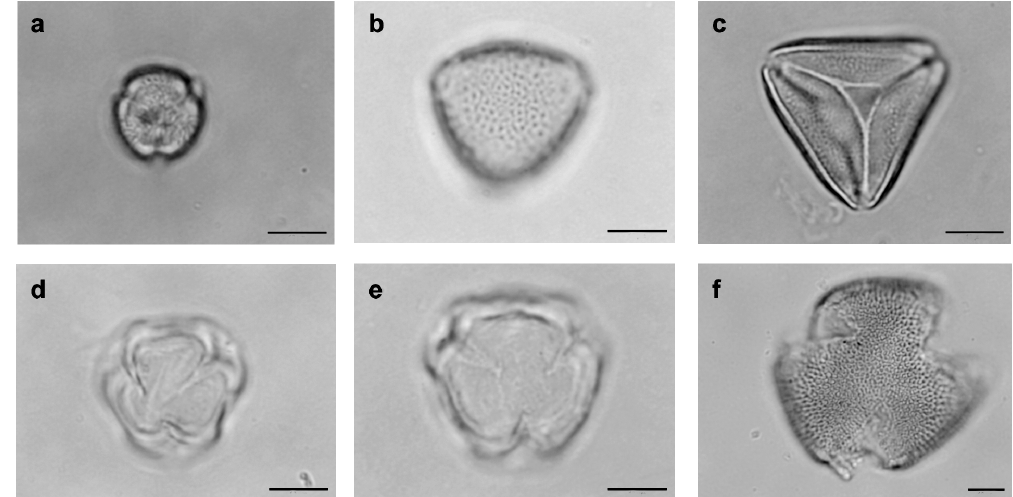
Figure 3. Pollen types from floral visiting bees’ bodies of Solanum dydimum at Araucarias Municipal Park in Guarapuava, Paraná state, Brazil. ( a – f ) Angiosperms, Eudicotyledons. ( a ) Rutaceae, Zanthoxylum . ( b ) Sapindaceae, Allophylus . ( c ) Sapindaceae, Matayba . ( d ) Solanaceae, Solanum . ( e ) Solanaceae, Solanum didymun (esxicatte). ( f ) Turneraceae, Turnera . (bar = 10 µm).